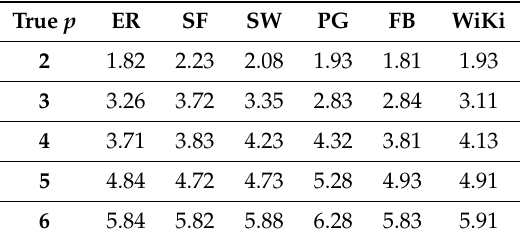
Table 1. Averaged value of estimations of parameter p using DPE ( K ) for general graphs ( K = 500). We use the step size δ = 0.1 and p max = 10. True p ER SF SW PG FB WiKi